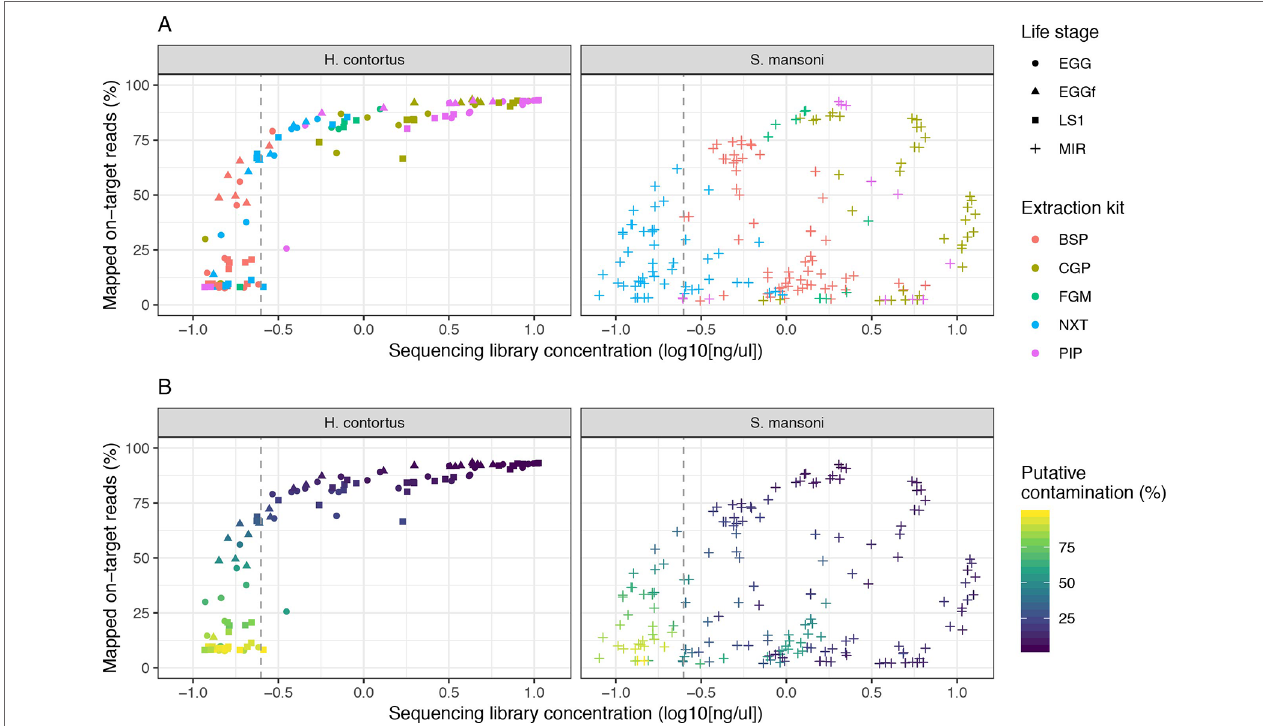
FIGURE 2 | Impact of sequencing library concentration on mapped on-target reads for five low-input DNA extraction protocols. Each point represents an individual sequencing library sample, colored by extraction protocol (A) or proportion of putative contaminating reads (100 - percent_unclassified_reads) (B) . The dashed grey vertical line represents a library concentration of 0.25 ng/µl. Extraction protocols were performed on Haemonchus contortus eggs (EGG), frozen eggs (EGGf), and L1 (LS1) stages, and Schistosoma mansoni miracidia (MIR). The number of samples in each comparison is presented in Table 1 , and the raw data used are described in Table S1